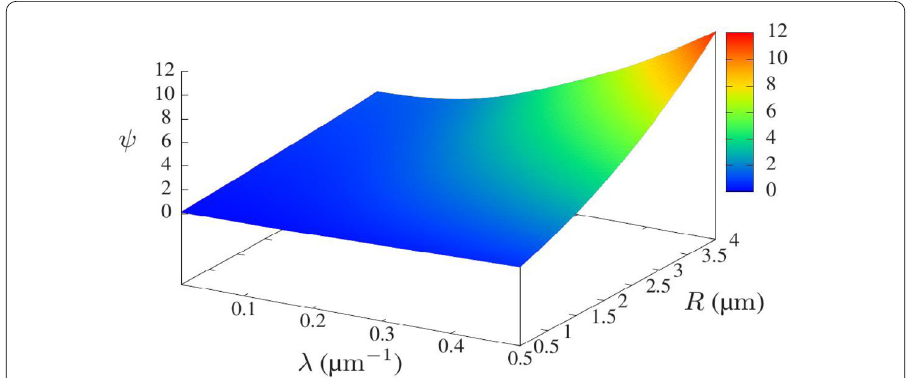
resembles qualitatively the square of sine or cosine waves whose amplitude decays as (cid:7) –4